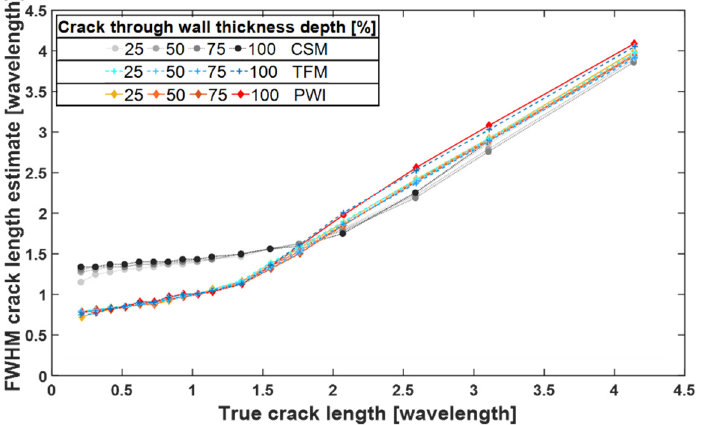
Figure 9. Comparison of FWHM sizing capabilities of CSM, TFM and PWI using FE simulations.